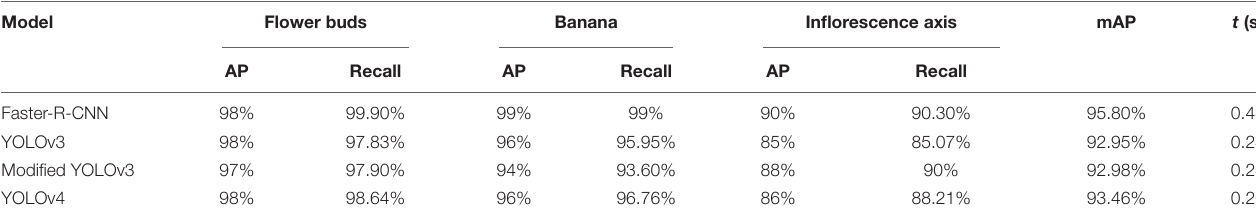
TABLE 2 | Comparison of the multi-target detection results between the YOLOv3 model, YOLOv3 model based on clustering optimization, R-CNN model and YOLOv4 model (238 images). Model Flower buds Banana Inflorescence axis mAP